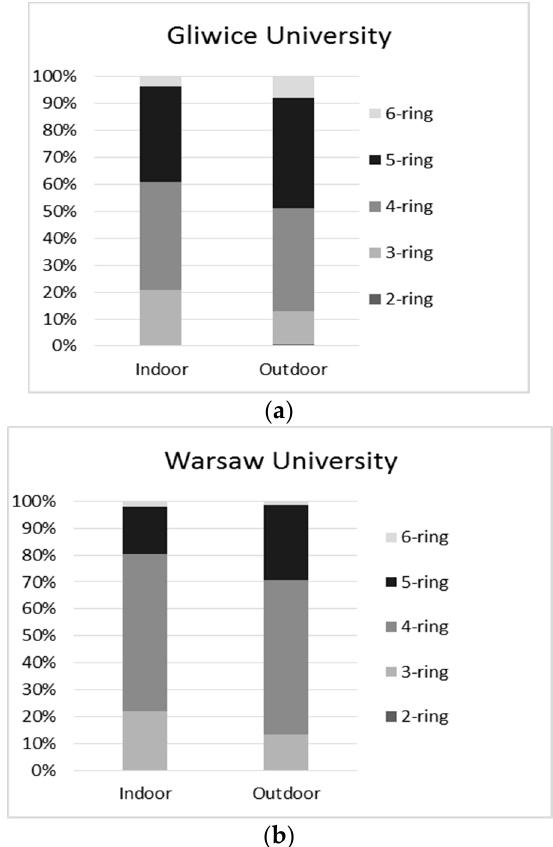
Figure 1. PAH distribution pattern in PM 1 samples from lecture halls at the sites in Gliwice ( a ) and Warsaw ( b ).